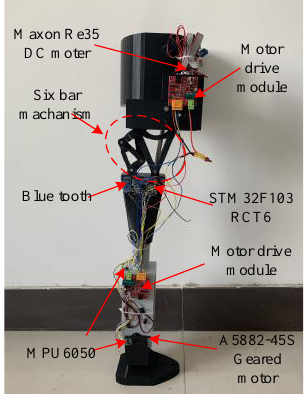
Figure 14. Prosthesis model.